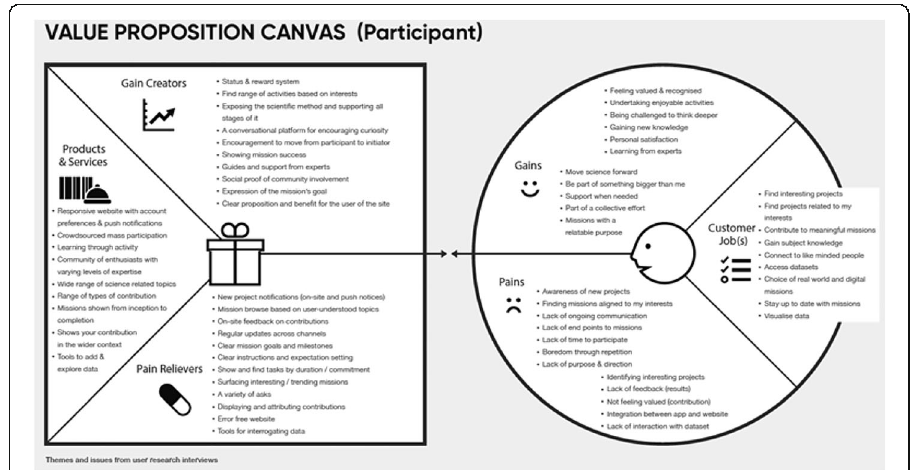
Fig. 5 Interview themes from the perspective of a mission participant